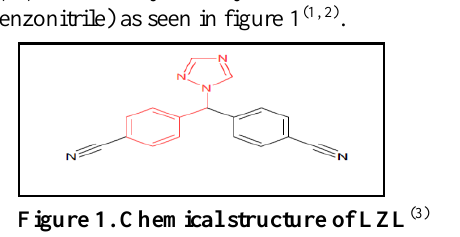
Figure 1. Chemical structure of LZL